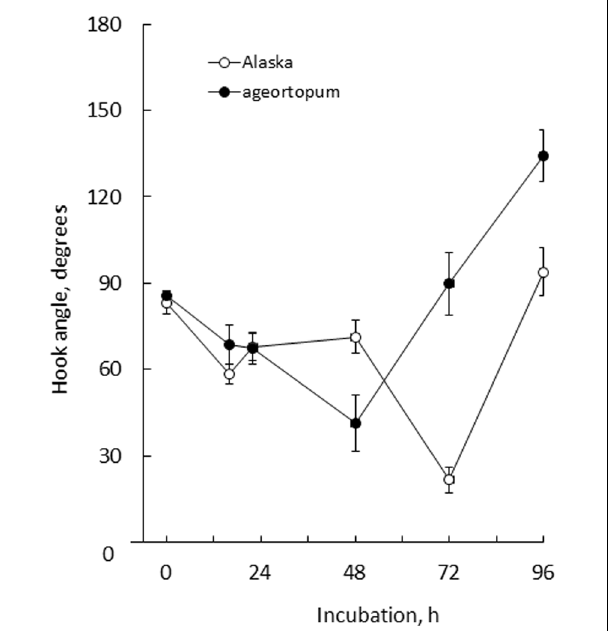
FIGURE 5 | Kinetics of the development of apical hooks inAlaska and ageotropum seedlings under 1- g conditions. Data points: the means with standard errors ( n = 10); time: h